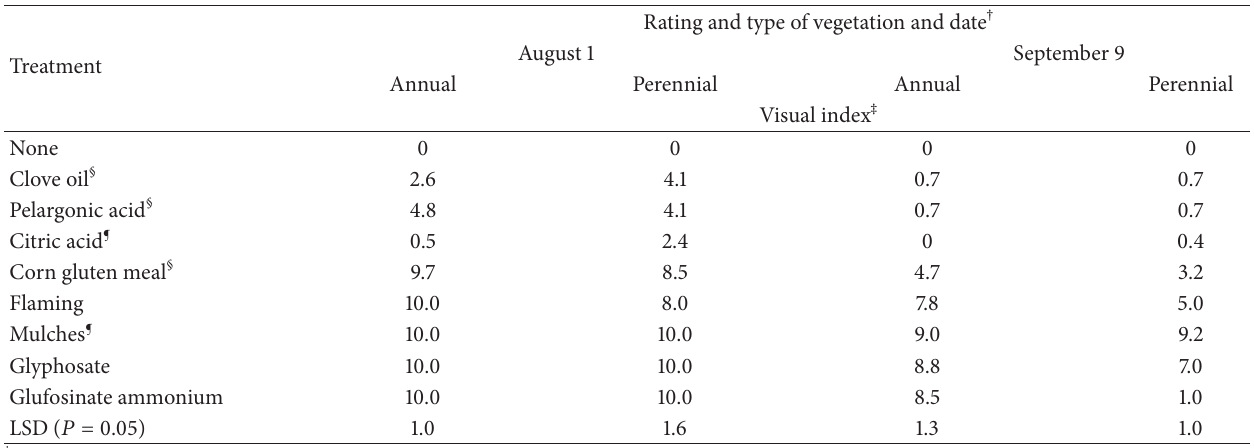
Table 5: Assessments of conventional and alternative herbicides and mechanical treatments on early season control of vegetation in field plots with annual and perennial vegetation (Field Experiment 1).